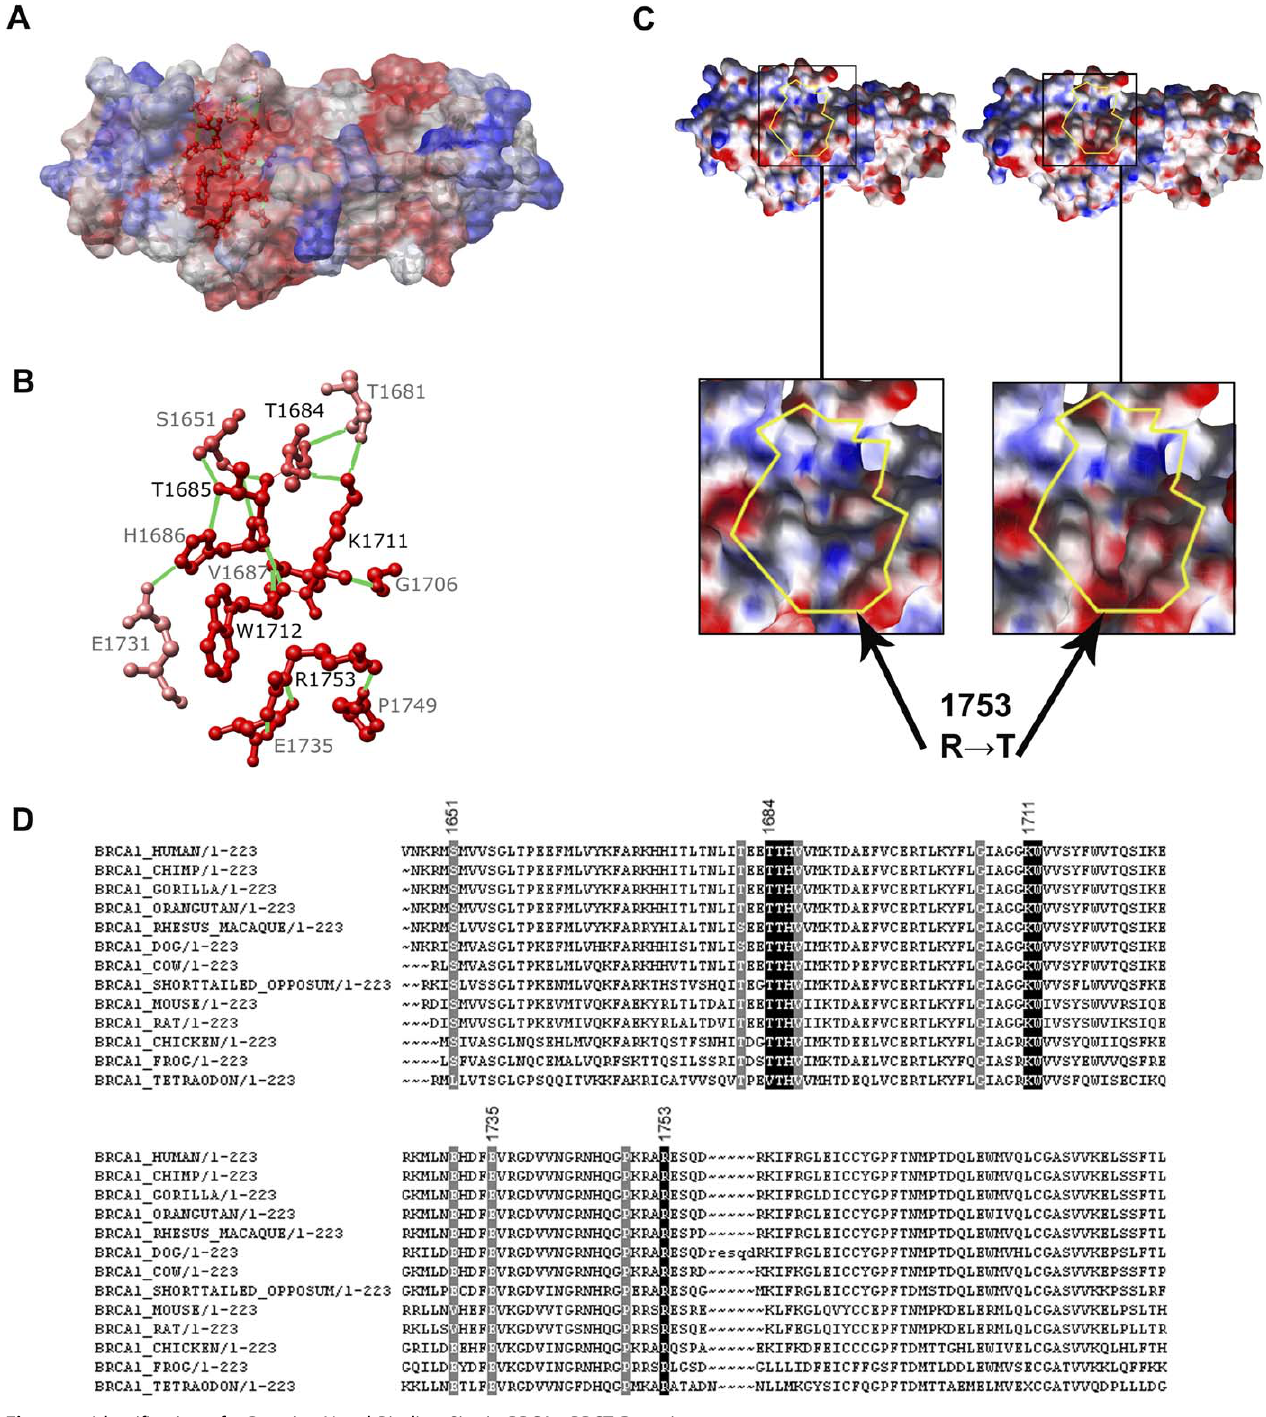
Figure 5. Identification of a Putative Novel Binding Site in BRCA1 BRCT Domains Two surface variants found to be deleterious to BRCA1 activity in our companion paper (R1753T and T1685I) [14] lie at a highly conserved patch of amino acid residues, forming a groove on the protein surface, possibly a heretofore uncharacterized binding site of BRCA1 with a protein partner or nucleotide ligand. (A) Surface representation of BRCA1 BRCT domains colored by conservation in our multiple sequence alignment of orthologs. Red, 100% conserved; white, 39% conserved; blue, 0% conserved. (B) Two hydrogen-bonding networks are shown in ball-and-stick format. (C) Changes in the electrostatic surface potential of the putative binding site upon mutation of R1753 to T1753. The electrostatic surface potential of the groove changes from primarily positive (greater than 10 k T) and neutral (0 k T), depicted as blue and white, to negative (less than (cid:2) 10 k T), depicted as red. This change may weaken the binding of protein partner(s) or nucleic acid ligand(s) necessary for BRCA1 9 s transactivation activity. Electrostatic surface potential calculated by DELPHI, visualized by CHIMERA in GRASP format [39,40,43]. (D) Multiple sequence alignment of BRCT domains in BRCA1 orthologs. Primary groove residues are shaded in black, and their hydrogen-bonding partners are shaded in gray. doi:10.1371/journal.pcbi.0030026.g005 PLoS Computational Biology |